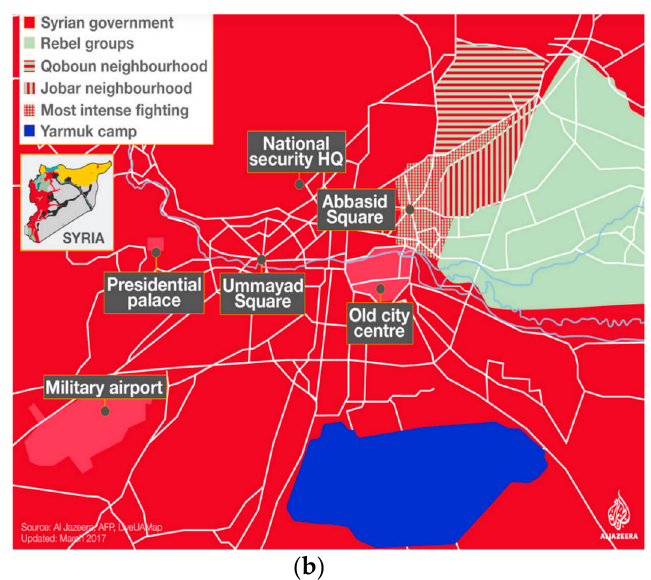
Figure 19. Comparison of Damascus standard deviation map ( a ) and territory map ( b ) produced by Aljazeera [50].